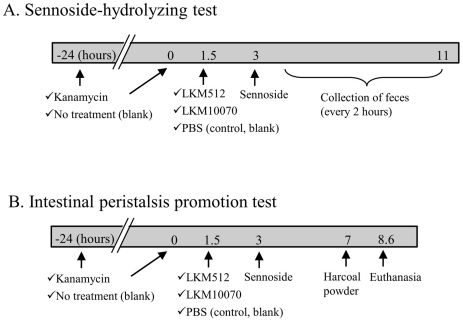
Time schedule of animal assay.These tests were performed individually (one mouse/cage). (A) Sennoside-hydrolysing test by Bifidobacterium spp. Feces were collected every 2 hours. (B) Intestinal peristalsis promotion test by LKM512. This test was performed using a pair of mice: 1 LKM512-administered mouse and 1 control mouse.